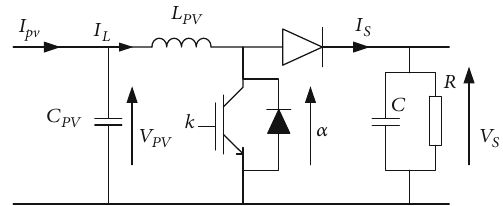
Figure 4: Circuit diagram of a DC-DC boost converter.